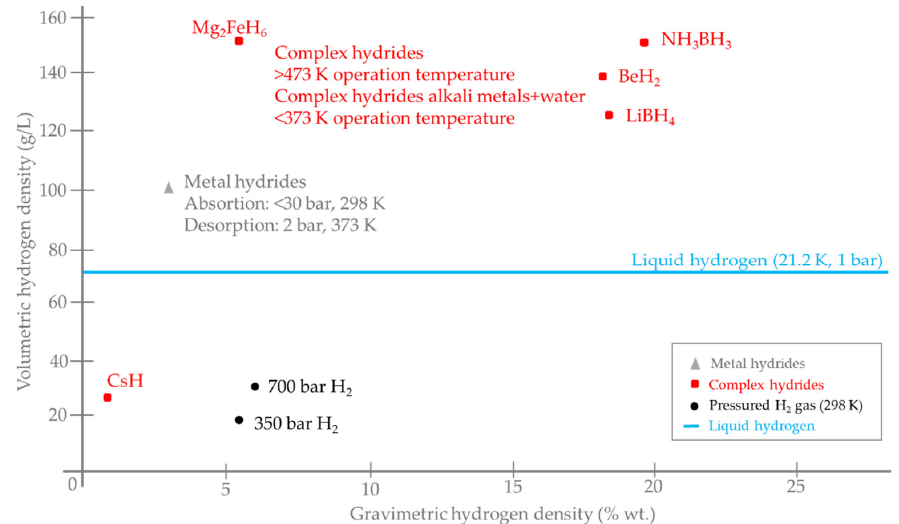
Figure 16. Alternatives for hydrogen storage: technical comparative. Table 11. Summary of technical parameters of commercial hydrogen storage technologies.